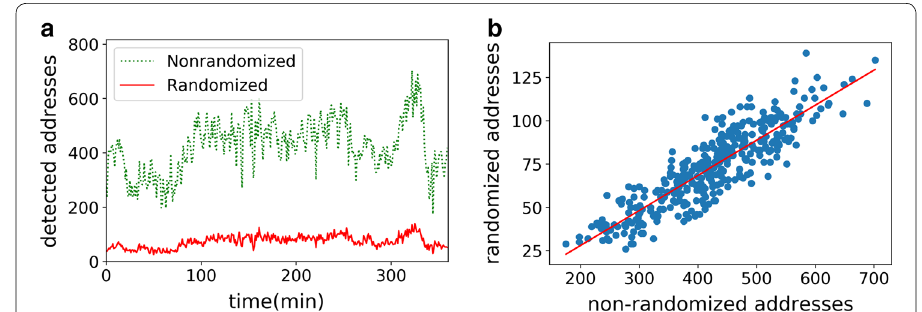
Fig. 4 a Number of non-randomized and randomized addresses observed per minute; b linear regression plot of randomized and non-randomized addresses observed per